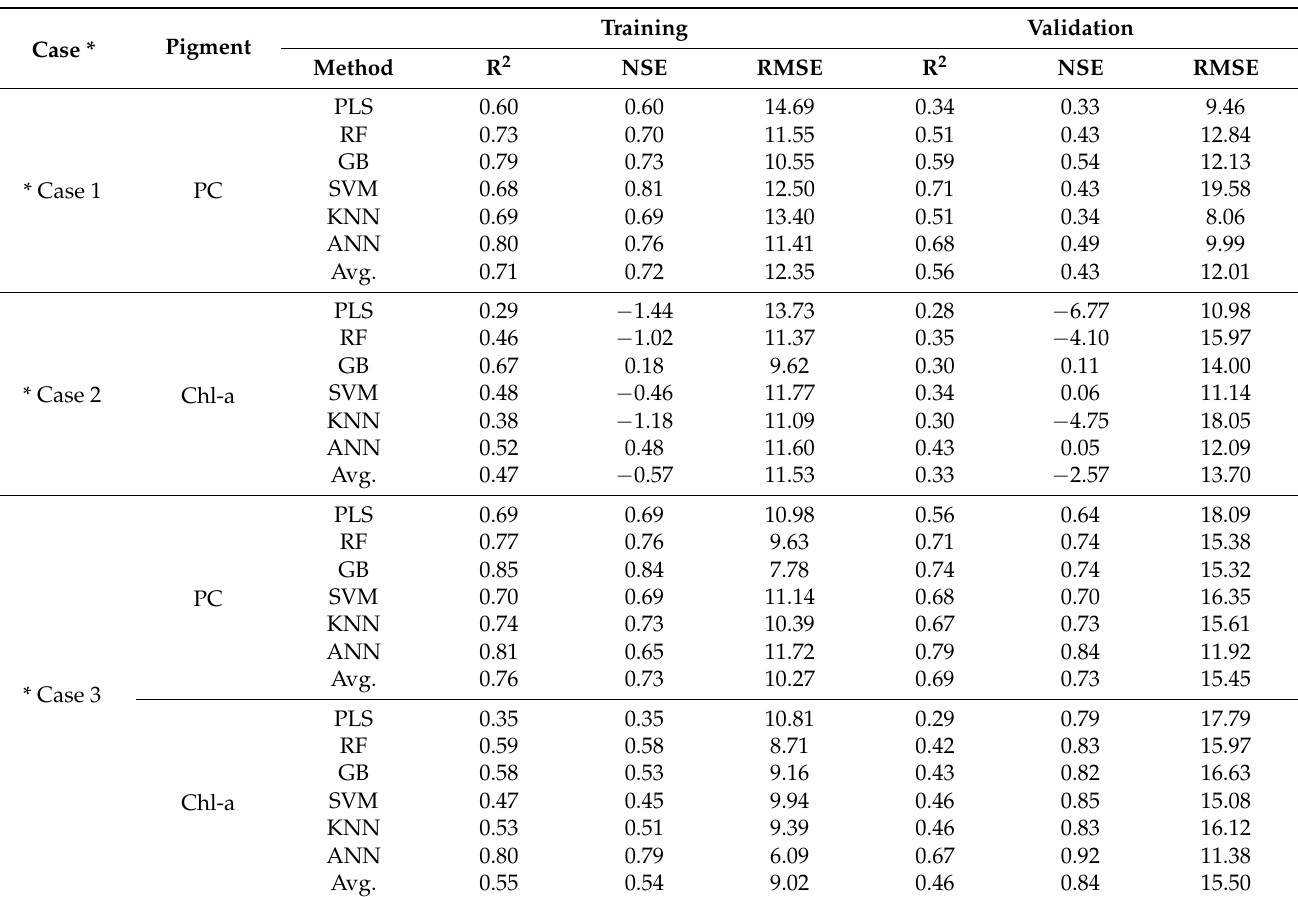
Table 4. Performances of six data-driven models on estimation of two pigments in terms of different input spectral band